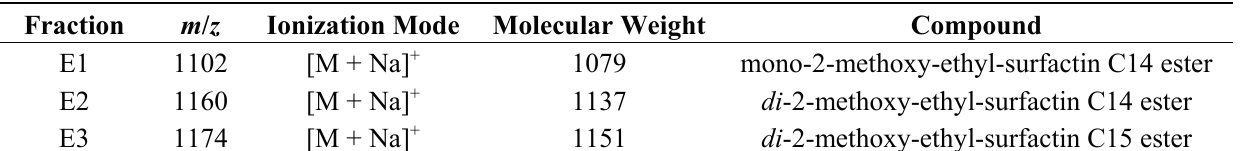
Table 2. Component identification results of E1, E2 and E3.